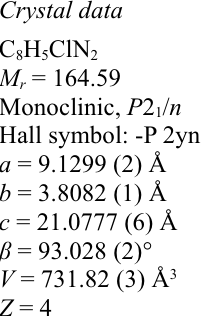
; the Cl···Cl contacts are shown as dashed bonds. 2